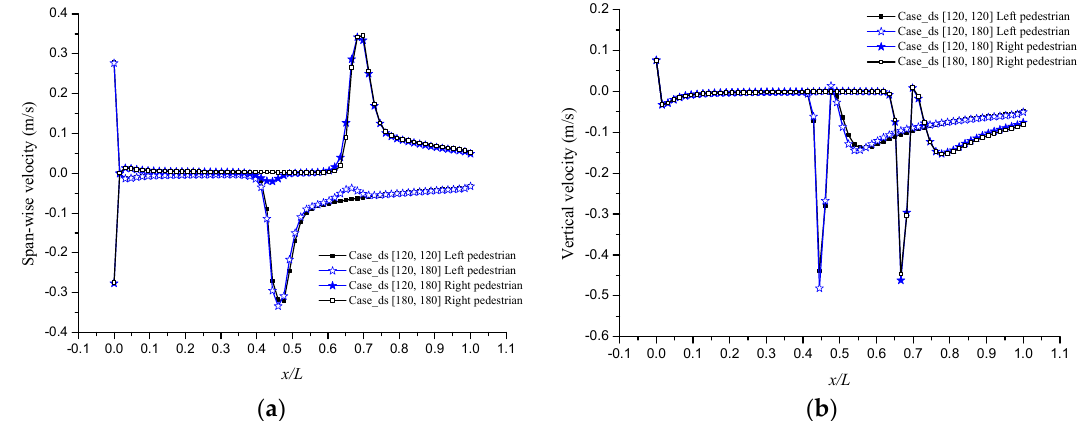
Figure 8. ( a ) Comparison of span-wise velocity between Case_ds [120, 120], Case_ds [120, 180] and Case_ds [180, 180]; ( b ) comparison of vertical velocity between Case_ds [120, 120], Case_ds [120, 180] and Case_ds [180, 180].